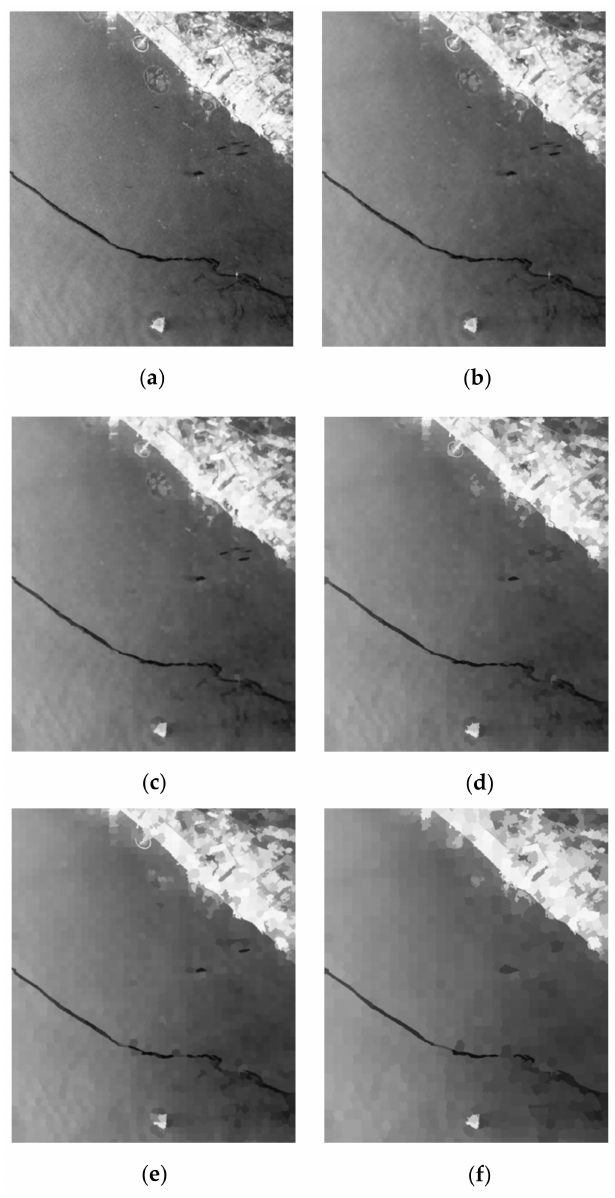
Figure 8. SLIC superpixel results of Image 8 using different superpixel number settings: ( a ) 50 × 50, ( b ) 75 × 75, ( c ) 100 × 100, ( d ) 125 × 125, ( e ) 150 × 150, and ( f ) 200 ×